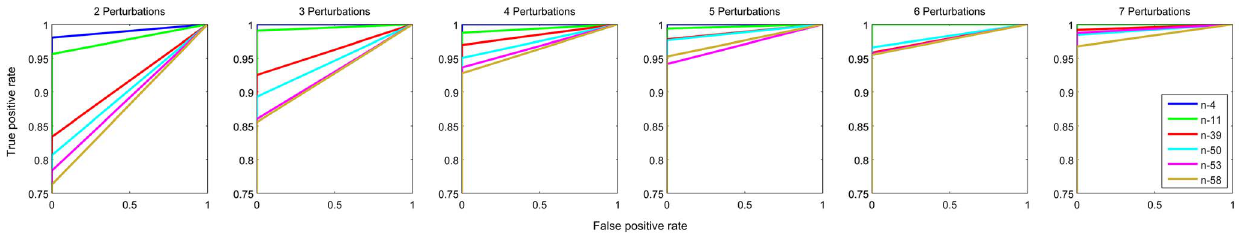
Figure 4. ROC curves of network structure inference. The performance of structure inference, under 6 different numbers of perturbations (from 2 to 7), is evaluated by ROC curves. Each subplot contains the inference results for 6 benchmark networks. The average AUROC is 0.97. More specifically, the maximum AUROC value 1.0 is achieved by the n-4 network (3–7 perturbations) and the n-11 network (6–7 perturbations), while the minimum AUROC value 0.88 is obtained by the n-58 network (2